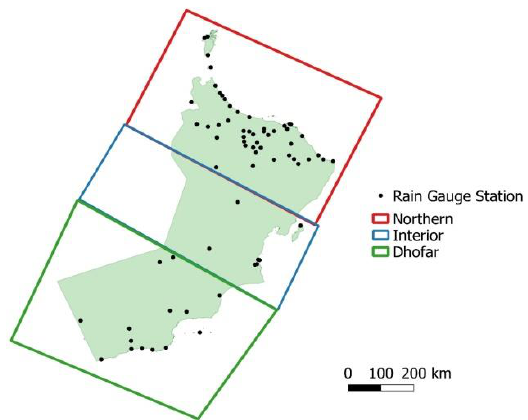
Figure 2. Rain gauge station locations and subdivisions of the study area classified by Oman’s rainfall pattern.